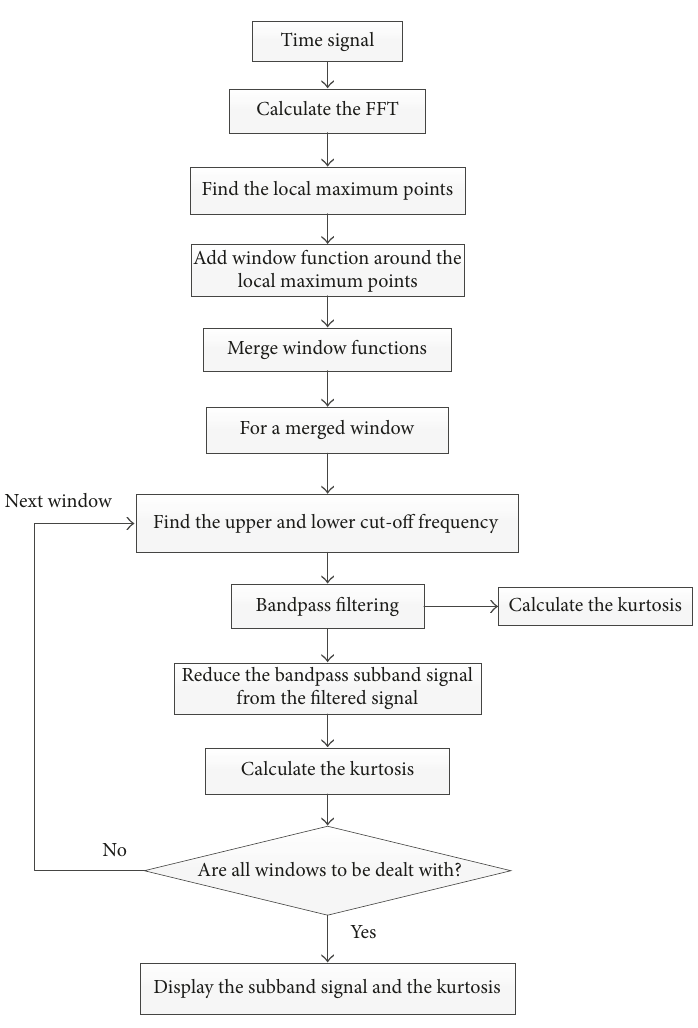
Figure 8: The framework of the proposed adaptive